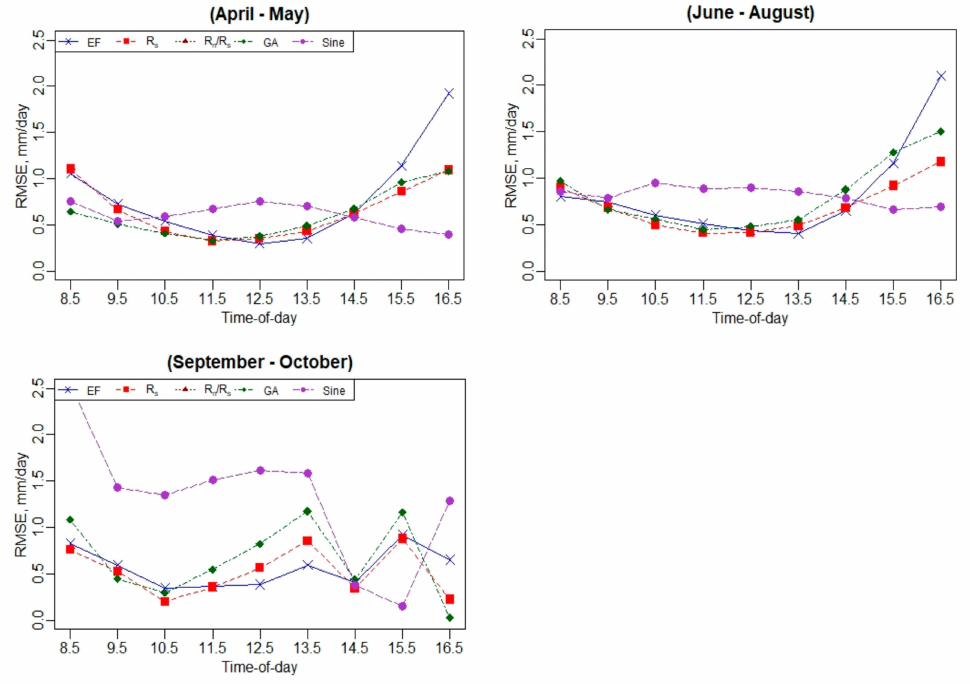
Figure A11. Daily RMSE performance using hourly EC ET values.